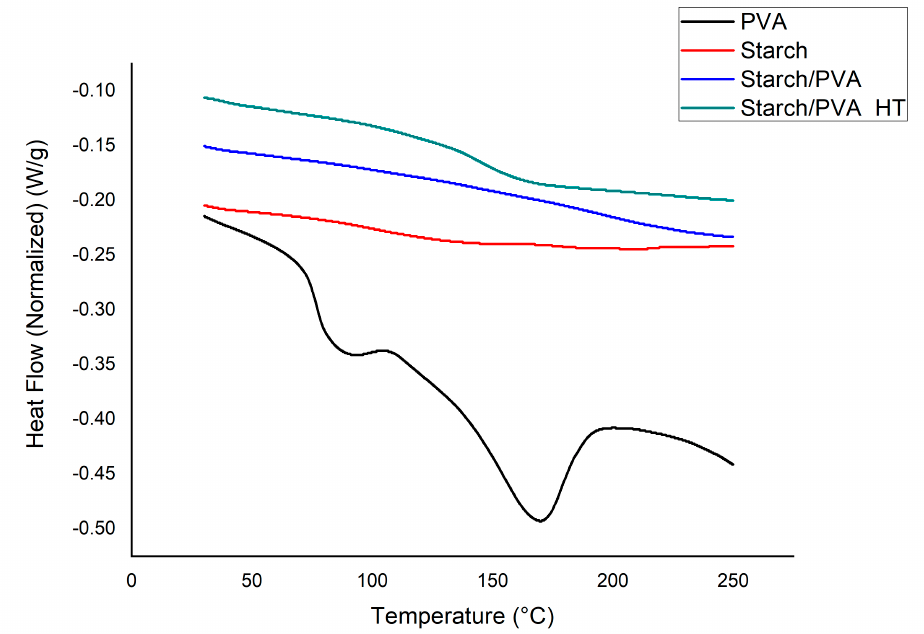
Figure 5. DSC thermograms of PVA, starch/PVA and starch/PVA